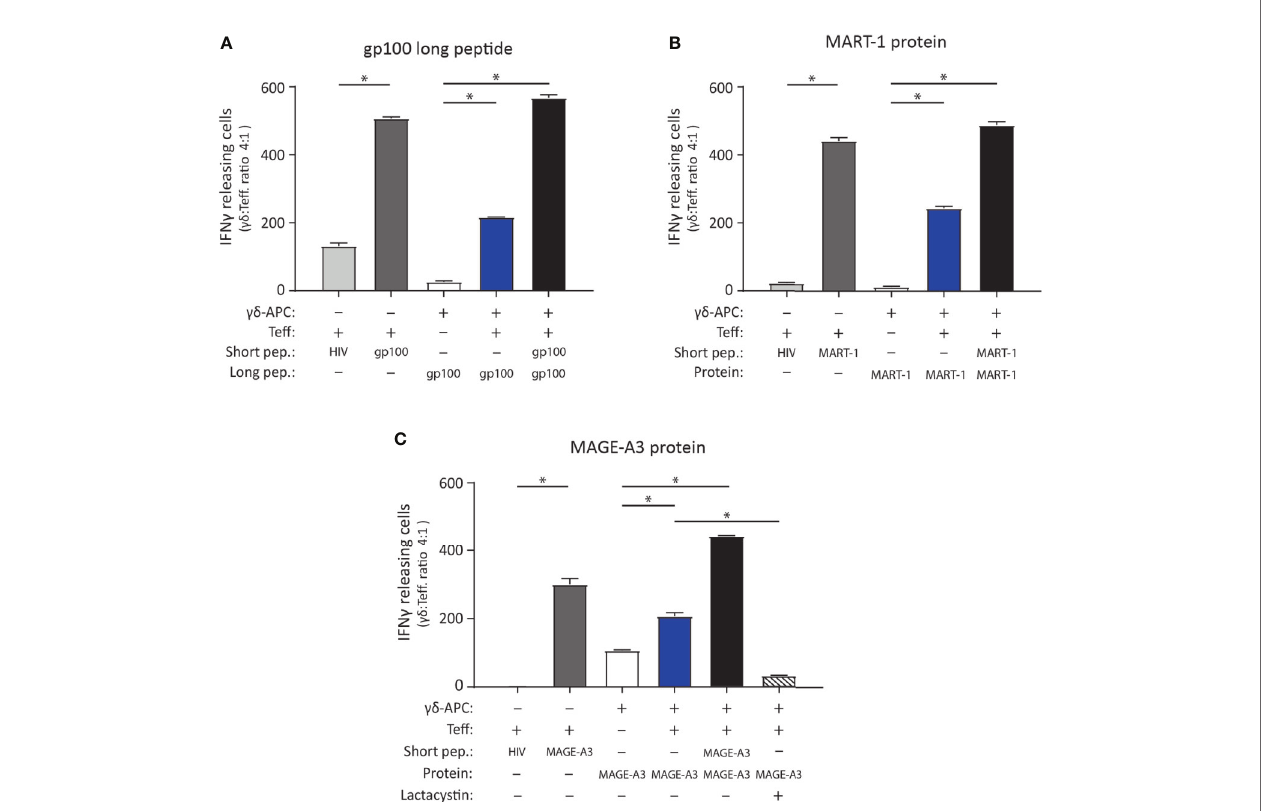
FIGURE 4 | V g 9V d 2 T cells can cross-present tumor antigen from long tumor peptides and tumor proteins. To test the ability of V g 9V d 2 T cells to cross-present tumor antigen, the experimental APC setup illustrated in Figure 3 was used. (A – C) Speci fi city of the tumor antigen speci fi c CD8 + ab TCR T cells which were used as effector cells in the APC assay, is shown by ELISPOT assay. This includes three different ab TCR T effecter cells (called ‘ Teff ’ ), being speci fi c for either gp100 (YLEPGPVTA, HLA-A*02.01-restricted), MART-1 (ELAGIGILTV, HLA-A*02.01-restricted) or MAGE-A3 peptide (EVDPIGHLY, HLA-A*01.01-restricted). Short peptides for gp100, MART-1 or MAGE-A3 peptides, were added to the ELISPOT wells as a positive control (5 nM) and con fi rmed speci fi city (dark grey bars) by comparison the unspeci fi c short HIV peptide (ILKEPVHGV), used as negative control (light grey bars in fi gure a, b and c). Peptide concentration was 5 nM. (n=3, triplicates). (A) Tumor antigen cross-presentation was measured using IFN g ELISPOT assay. Cross-presentation of a long gp100 peptide (29aa, 0.5 µM), recognized by gp100 speci fi c ab TCR cells (Teff.) (n=3 triplicates). (B) Cross-presentation of MART-1 recombinant protein (118aa, 1.25 nM), recognized by MART-1 speci fi c ab TCR effector cells (T.eff) (n=3 triplictes). (C) Cross-presentation of MAGE-A3 recombinant protein (314aa, 27 nM), recognized by MAGE-A3 speci fi c ab TCR effector cells (Teff). Additionally, inhibition of cross-presentation of the MAGE-A3 recombinant protein was shown by addition of 50 µM lactacystin (proteasome inhibitor) (n=3, repeated in 4 independent experiments). gd -APC refers to the V g 9V d 2 T cells that served as APC for antigen presentation, Teff refers to the ab TCR T effector cells, pep = peptide. All experiments were carried out in triplicates, and distribution free resampling (DFR) method was used for statistical analysis. P-value ≤ 0.05 (*) were considered statistically signi fi cant. Error bars indicated